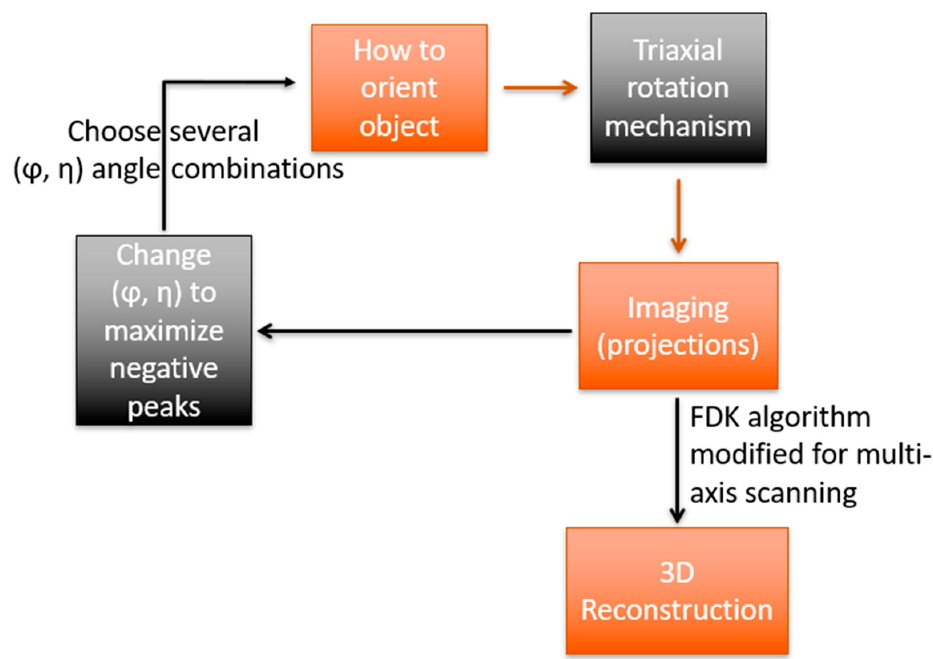
Figure 4. Partial architecture based on “Optimization of multi-axis control for metal artifact reduction in X-ray computed tomography” by Kano and Koseki [16]. ϕ and η are the two rotation angles in voxel space, describing the tilts of 3D space on the stage. These are separate from the classical 360° rotation of the stage itself during an individual scan.